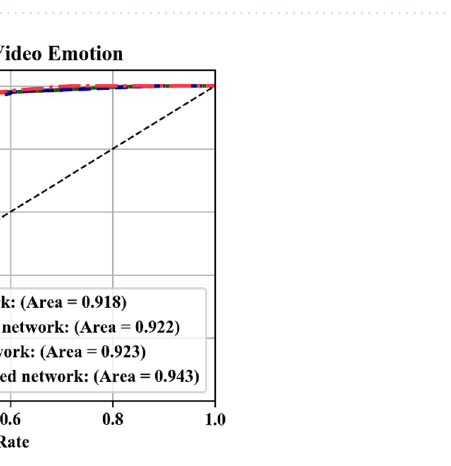
Figure 9. Confusion Metrix of the best performing multimodal using 50 test sample from each class. (Left) confusion matrix of music-video classifier and (right) confusion matrix of separable slow–fast network.